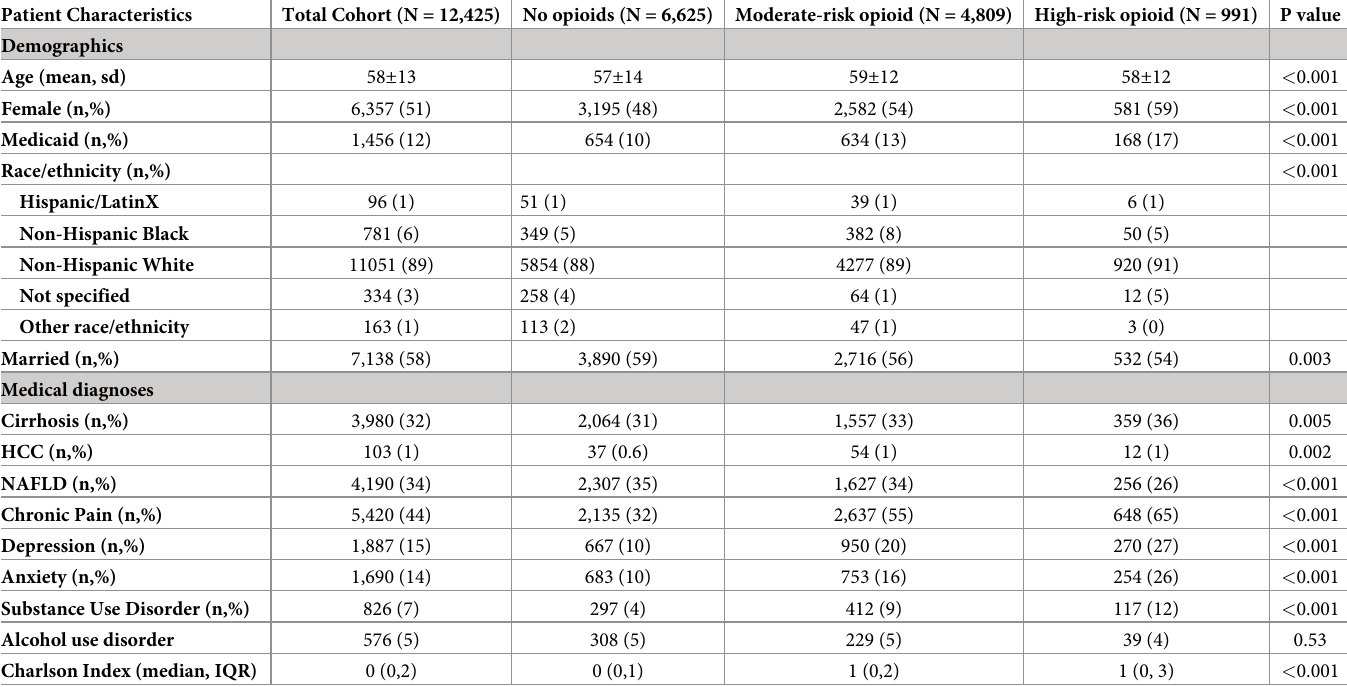
Table 1. Baseline characteristics of 12,425 patients with chronic liver disease, overall and by opioid prescriptions over follow-up. Patient